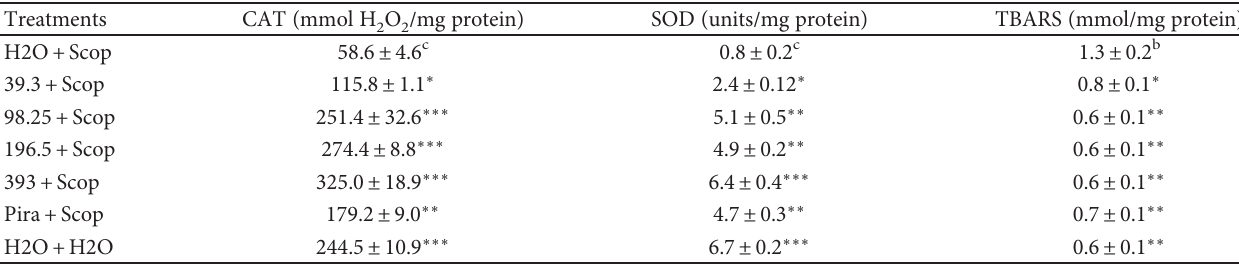
Table 6: Chemical evaluation of CAT, SOD, and MDA activities.